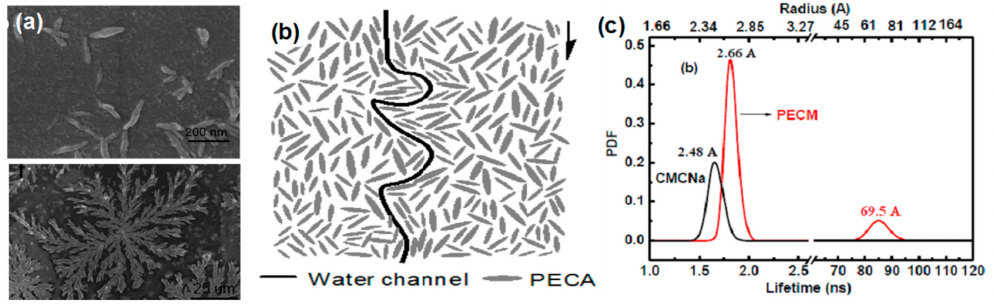
Figure 14. ( a ) SEM morphology for HPEC particles, ( b ) schematic diagram for water channel in HPECM, and ( c ) o-Ps lifetime distributions data for CMCNa and HPECM membranes. (PDF: Probability Density Function). Reproduced with permission from Reference